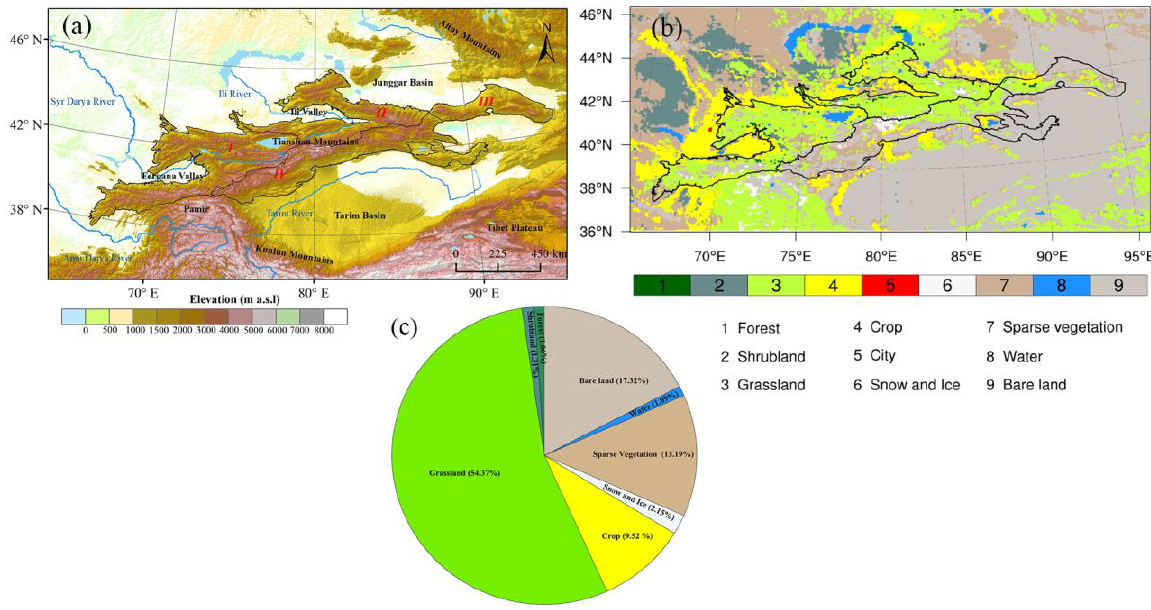
Figure 1. ( a ) Topography (m), ( b ) land cover type (conversion from basis land over in the WRF second simulation domain), and ( c ) each type fraction in the Tianshan Mountains.